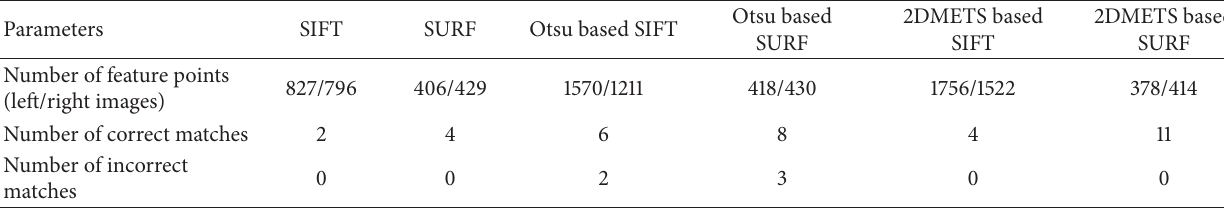
Table 3: Matching performance for images in group 3.